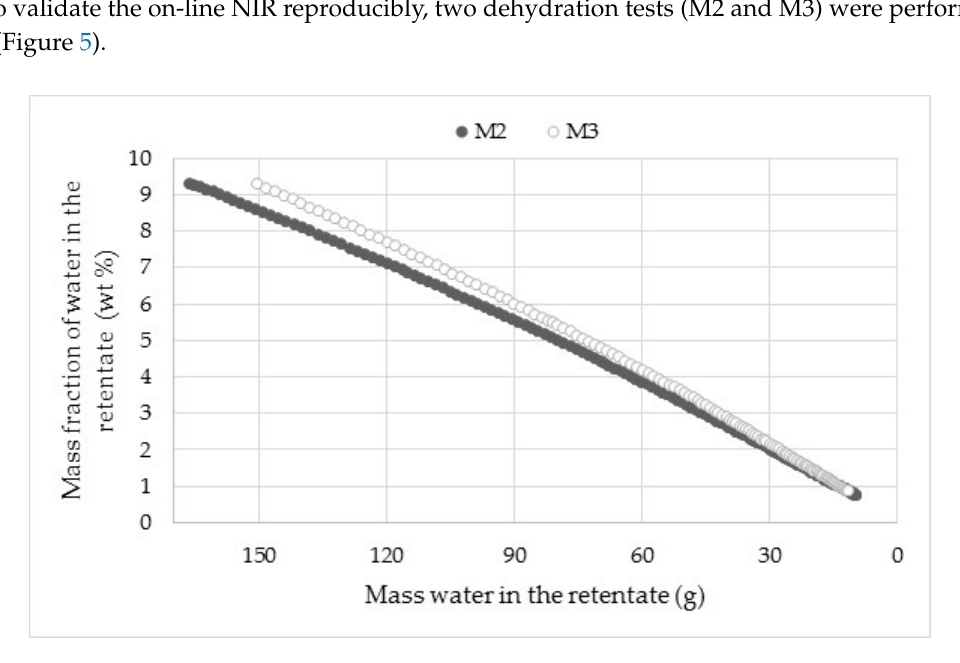
Figure 5. Reproducibility of on-line monitoring of acetone content versus mass water in the retentate through the HybSi ® membrane at 30 °C.